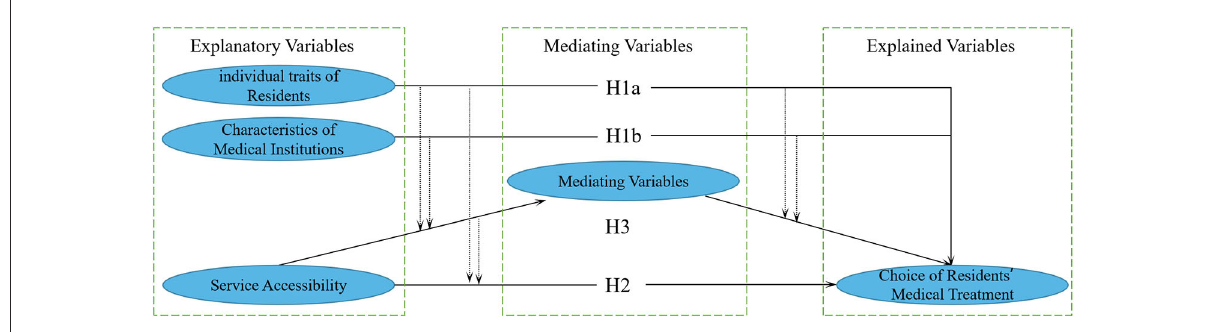
FIGURE2 Hypothetical framework of the research on residents’ choices of medical